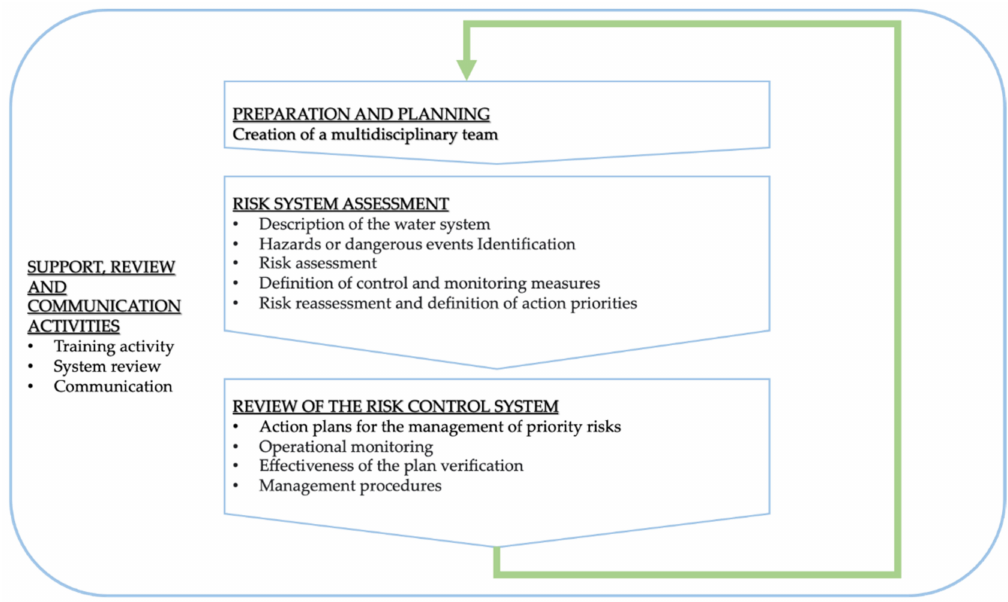
Figure 1. Methodological steps for developing a WSP to apply to a drinking-water system